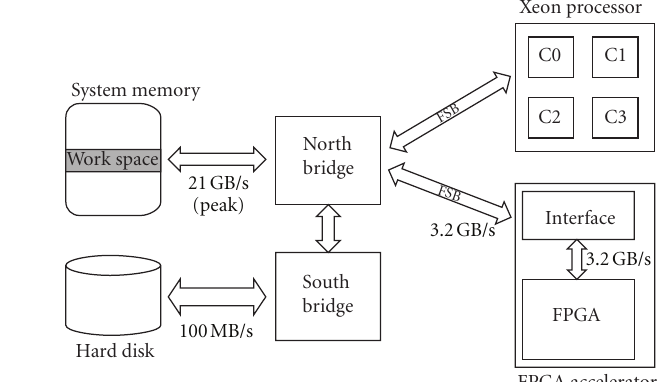
Figure 5: Nallatech